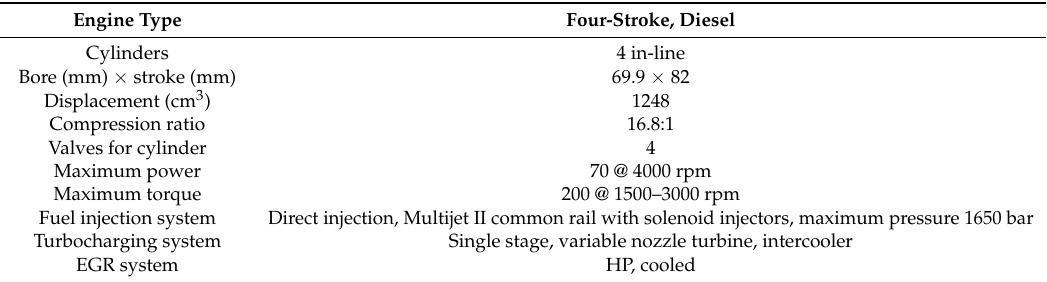
Table 1. Characteristics of tested engine. EGR: exhaust gas recirculation; and HP: high pressure.